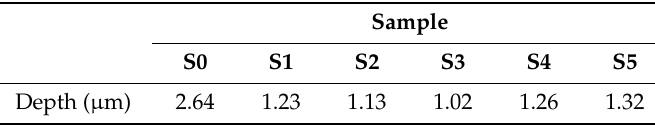
Figure 10. Microscopic image ( a ) and element distributions ( b – g ) in the friction area of sample S1. Parameters-load 15 N, time 15 min. Table 5. Abrasion track depths for the examined samples with the load of 15 N and for the time of 15 min